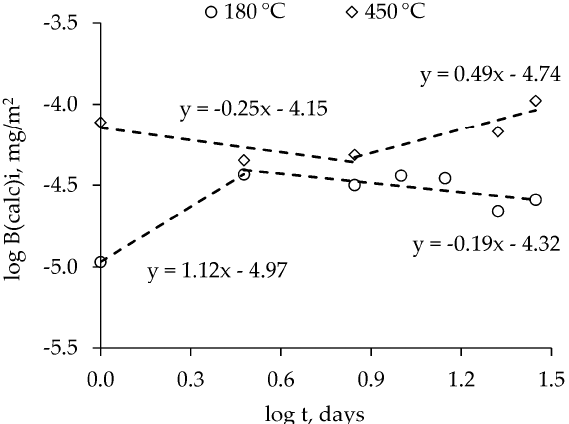
Figure 4. Logarithmic dependence of the 137 Cs release from MPP-FKN-W compound samples on contact time with water.